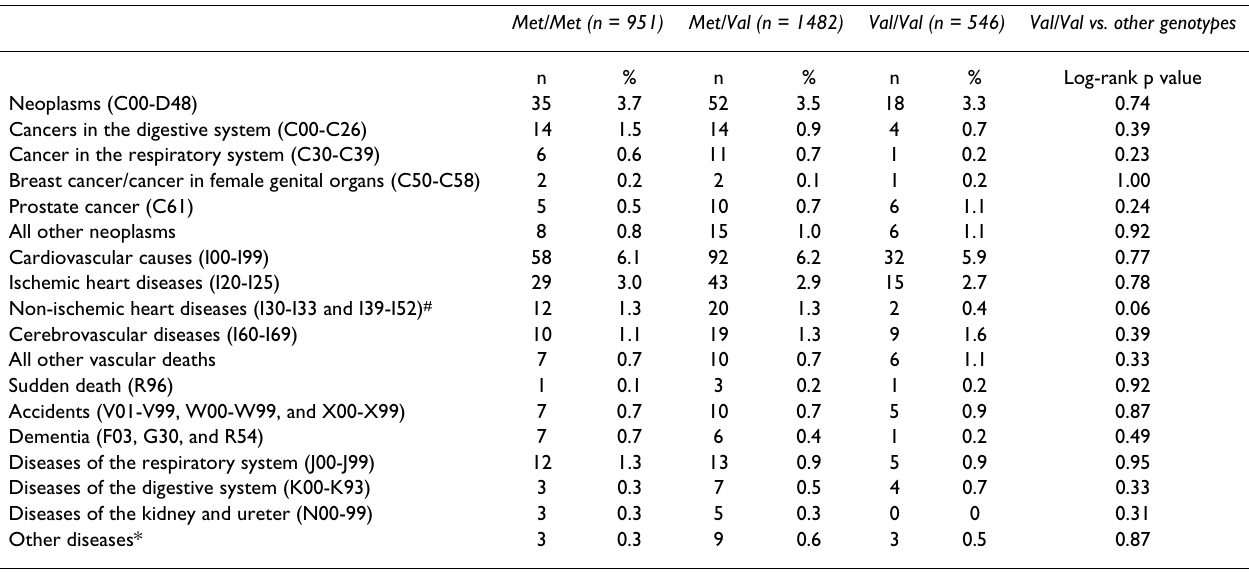
Table 4: Causes of death according to COMT